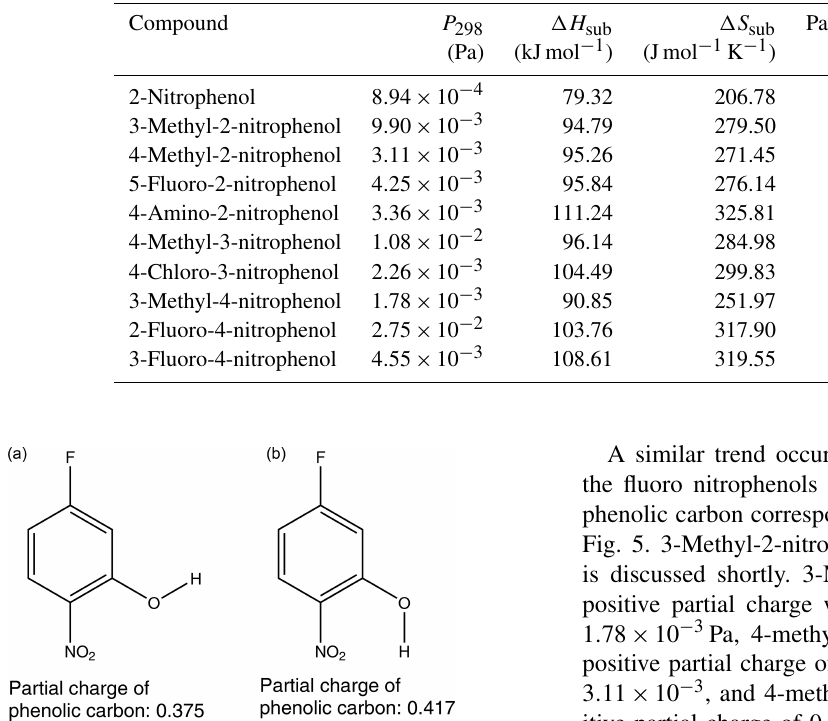
Table 4. P sat at 298K, enthalpies and entropies of sublimation, and partial charge of the phenolic carbon of nitrophenols determined using S KEMS.